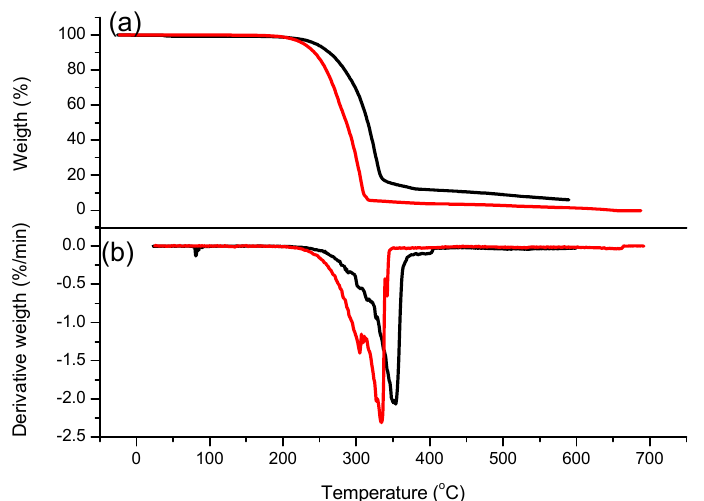
Figure 3. TGA ( a ) e DTG ( b ) analysis of DADB (–) and DEADP (–) in N 2 atmosphere at rate heating of 10 °C min − 1 .